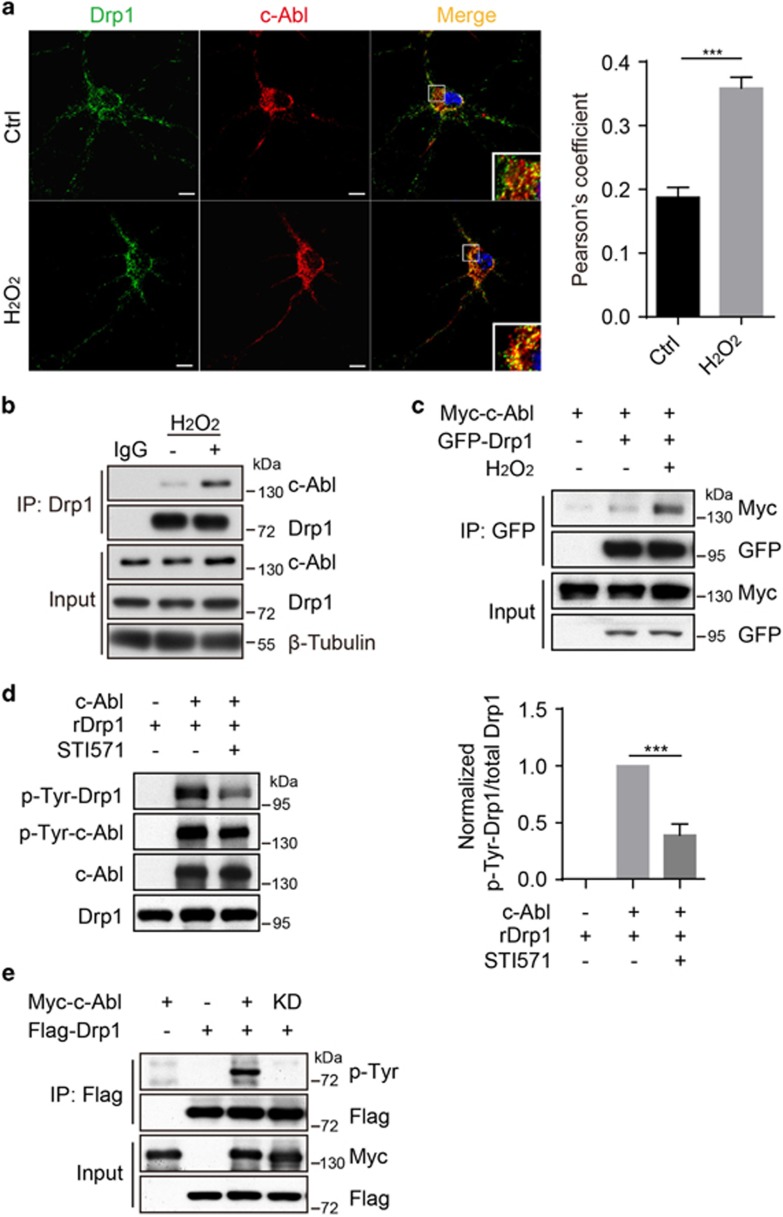
c-Abl interacts with and phosphorylates Drp1. (a) Left panel: primary cortical neurons were immunostained with the anti-Drp1 and anti-c-Abl antibodies after 100 μM H2O2 treatment or not for 0.5 h, followed by confocal microscopy. Right panel: Pearson’s correlation coefficient (Student’s t-test, ***P<0.001, n=4). (b) Lysates of primary cortical neurons with or without 100 μM H2O2 treatment for 0.5 h were immunoprecipitated with the anti-Drp1 antibody followed by immunoblotting with the anti-c-Abl antibody. (c) Lysates from HEK-293T cells transfected with expression plasmids Myc-c-Abl and GFP-Drp1 with or without 1 mM H2O2 treatment for 0.5 h were immunoprecipitated with anti-GFP antibody and subjected to immunoblot with the anti-Myc antibody. (d) Left panel: c-Abl kinase was subjected to an in vitro kinase assay using the recombinant full-length His-sumo-Drp1 (rDrp1) as a substrate with or without 10 μM STI571 treatment. Phosphorylation was analyzed by immunoblotting with anti-phospho-tyrosine antibody. Right panel: The normalized levels of p-Tyr-Drp1. (Student’s t-test, ***P<0.001, n=3). (e) Lysates from HEK 293T cells transfected with the Flag-Drp1 and Myc-c-Abl-WT or Myc-c-Abl-KD (kinase dead) expression plasmids were immunoprecipitated with anti-Flag antibody, then immunoblotted with anti-phospho-tyrosine antibody